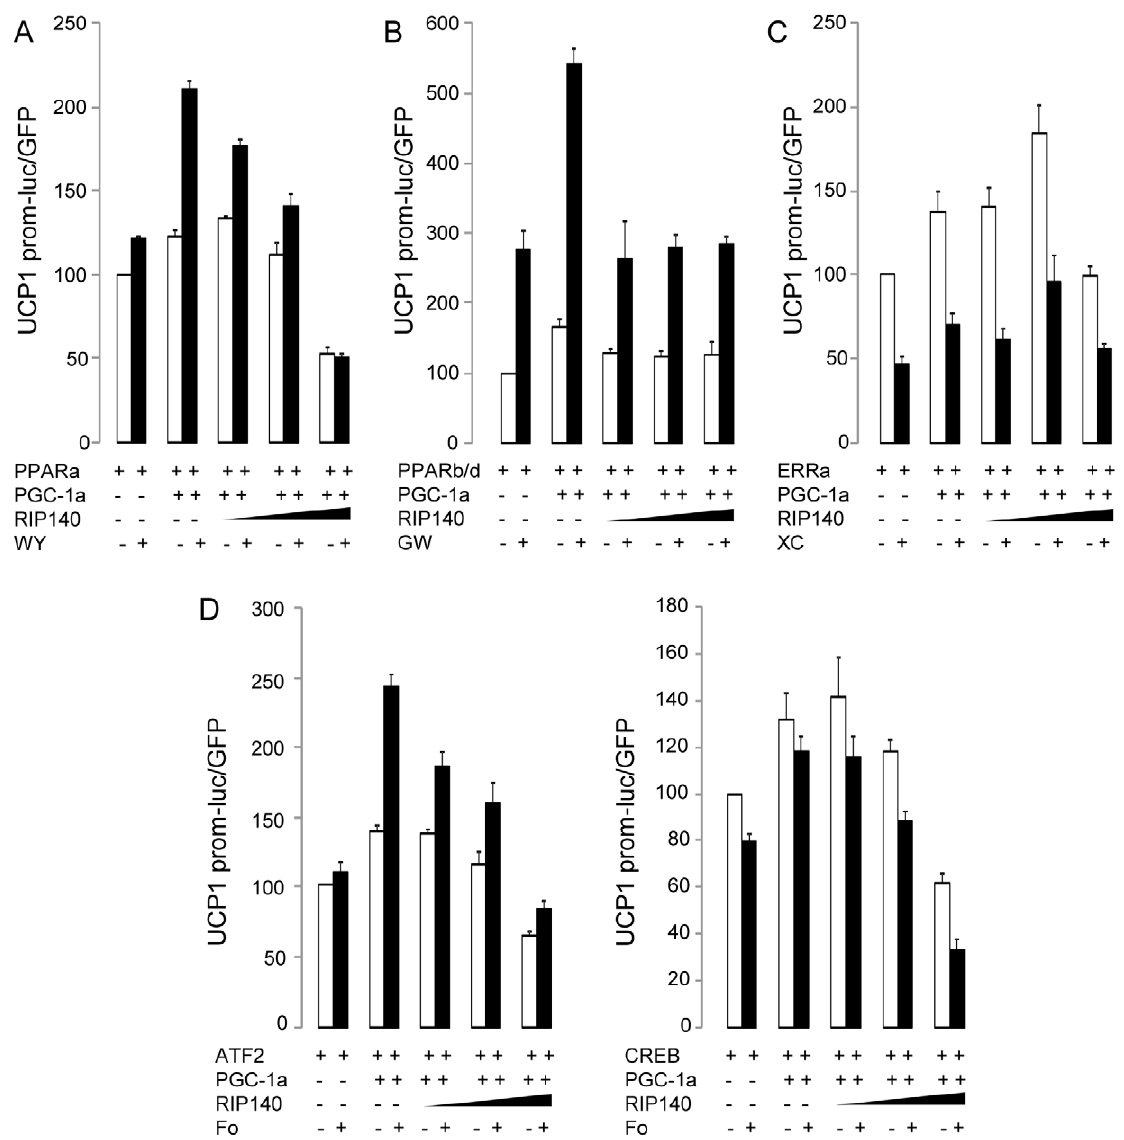
Figure 8. UCP1 promoter activity is induced by PGC-1 a and inhibited by RIP140 in C2C12. Cells were transfected with UCP1(4 kb)- luciferase reporter and vectors expressing (A) PPAR a , (B) PPAR b / d , (C) ERR a , (D) CREB or ATF2 with or without a vector expressing PGC-1 a , and increasing amount of RIP140 (0,01:1; 0,1:1 and 1:1 relative to PGC-1 a ), and treated with (A) 100 m M WY14643 (WY), (B) 10 m M GW501516 (GW), (C) 10 m M XCT790 (XC), (D) 10 m M Forskolin (Fo) or vehicle (-) as indicated. Data are expressed as mean 6